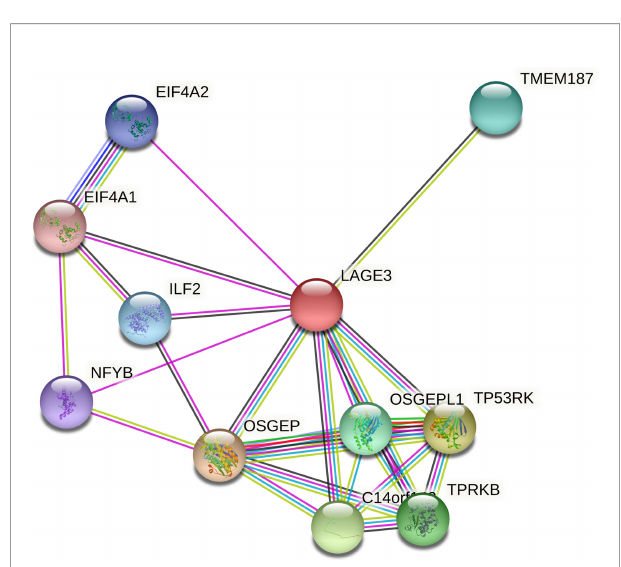
FIGURE 4 | PPI network of LAGE3 protein by the STRING online tool. Top 10 LAGE3-interaction proteins in HCC